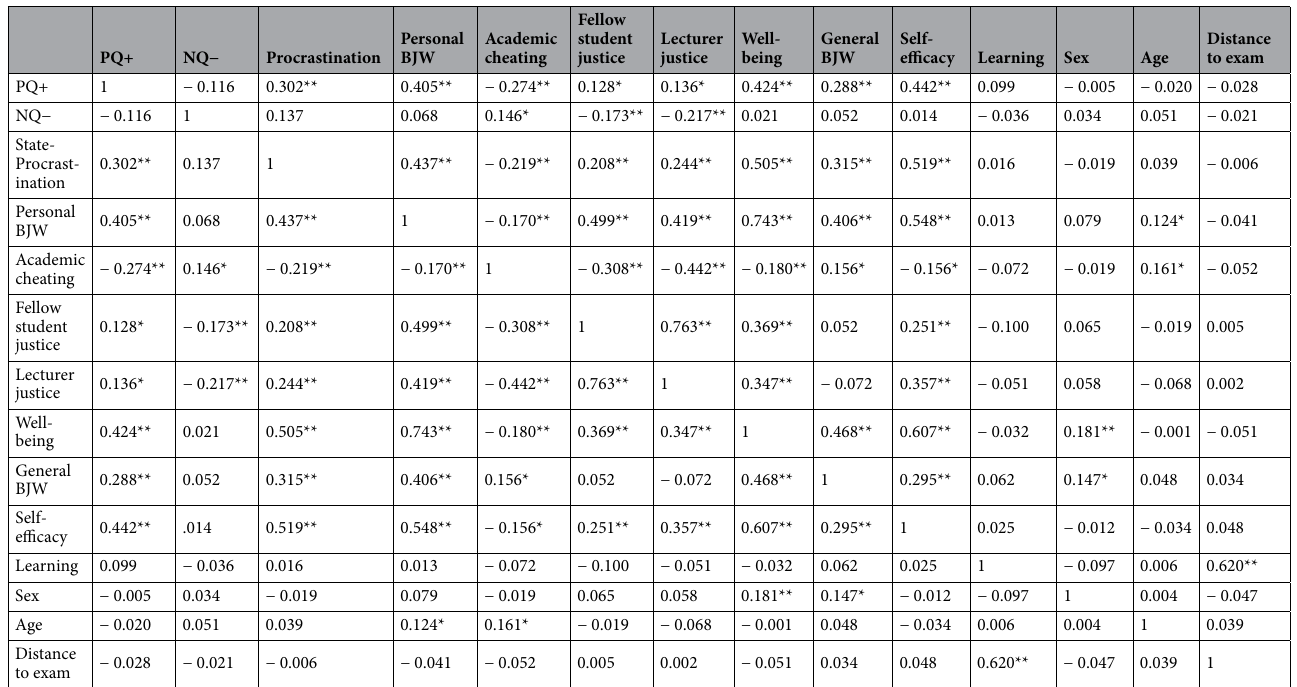
Table 1. Bivariate correlations and descriptive statistics of study variables (N = 291 university students). For sex, 1 = female and 2 = male; for learning, 1 = yes, 2 = no; for distance to exam, 1 = up to 3 weeks, 2 = between 3-6 weeks, 3 = later then 6 weeks; psychological variables ranged from 1 to 6 with lower values indicating stronger endorsement of the constructs, procrastination ranged from 1 to 5 with higher values indicating stronger endorsement of the constructs; BJW = belief in a just world; PQ+ = overstatement of positive qualities; NQ- = understatement of negative qualities. Correlations: point-biserial correlation between dichotomous and continuous variables; product-moment correlation between continuous